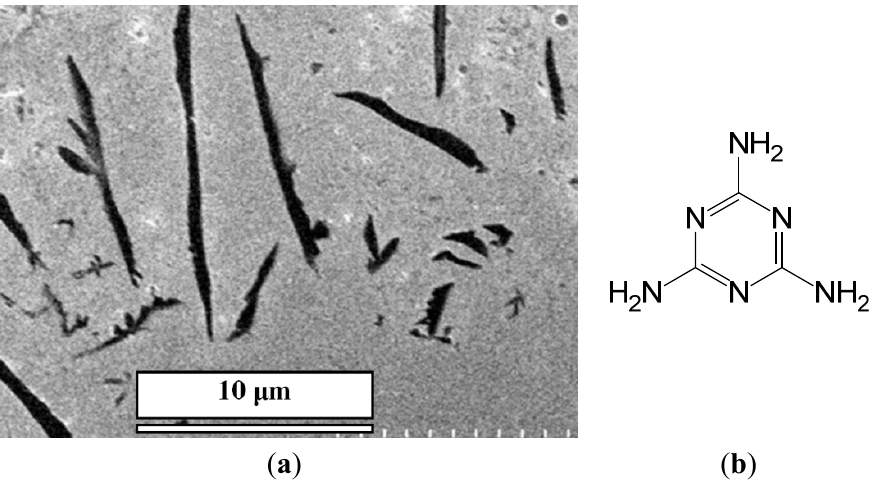
Figure 2. ( a ) SEM images of white precipitation film of M alone after evaporation of water; ( b ) The structure of